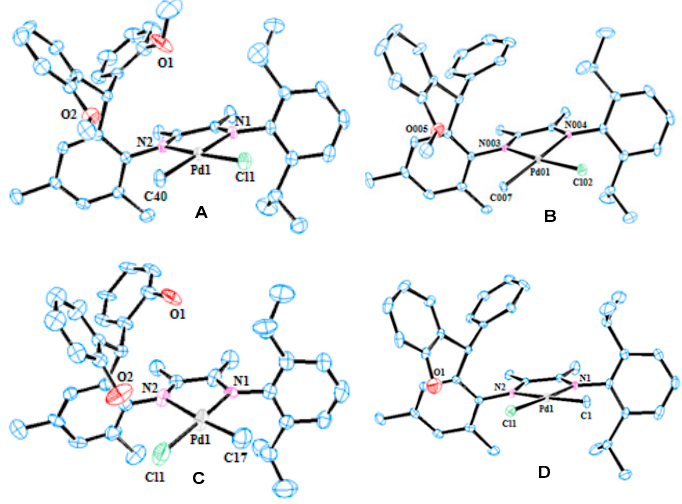
Figure 1. Molecular structures of: ( A ) Pd1 , ( B ) Pd2 , ( C ) Pd3 , and ( D ) Pd4 . Hydrogen atoms have been omitted for clarity. Selected bond lengths (Å) and angles (°) for Pd1 (CCDC. 1941586): Pd1-N1 = 2.158(5), Pd1-Cl1 = 2.3017(2), Pd1-N2 = 2.056(6), Pd1-C40 = 2.037(6); N1-Pd-N2 = 77.5(2), N1-Pd-C40 =